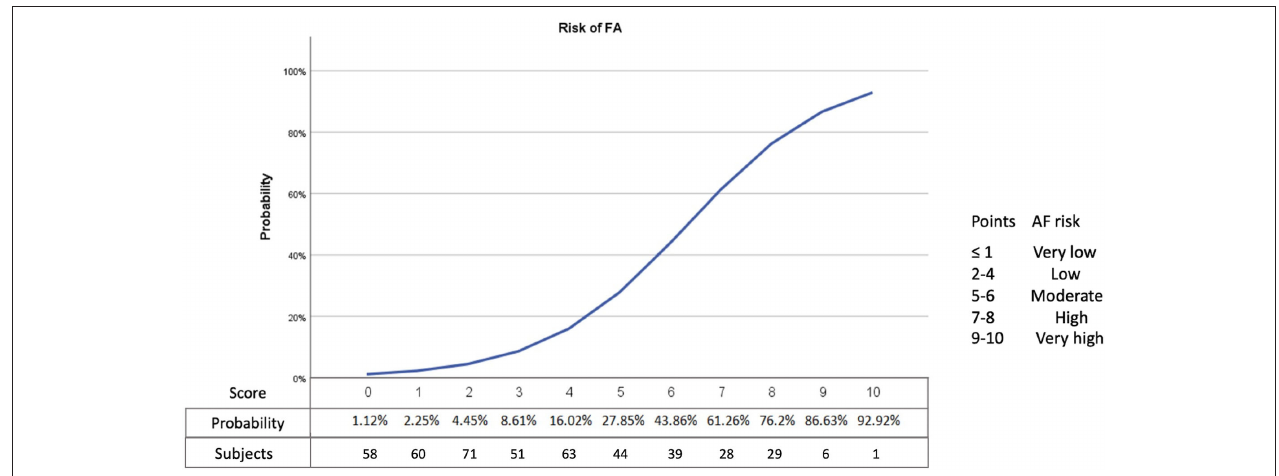
FIGURE 3 | Representation of the risk of AF (percentage) according to the SAFE score. AF, atrial fibrillation.